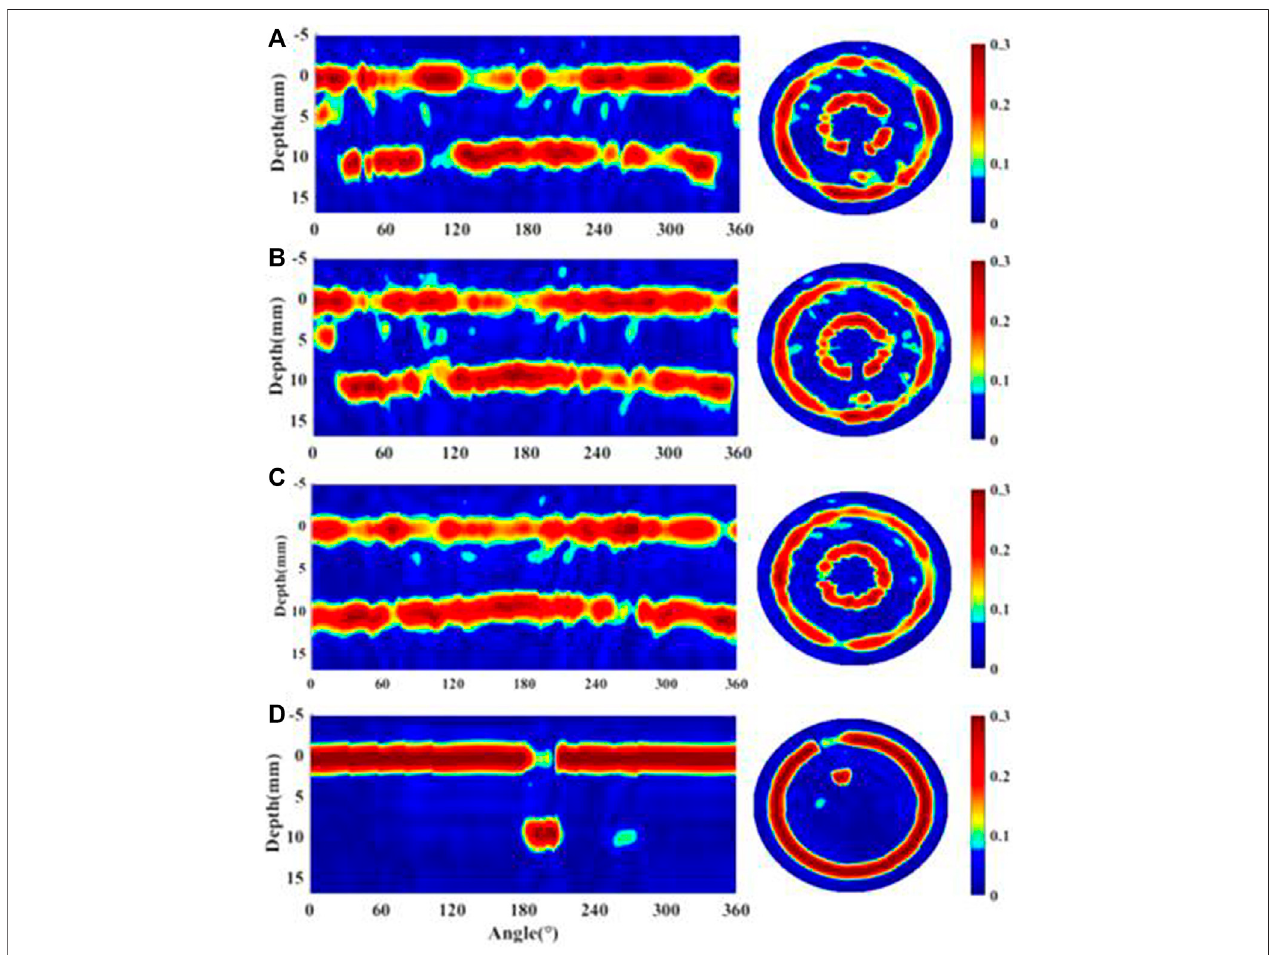
FIGURE 6 | THz B-scan images at different height positions in Cartesian and column coordinates. (A) 15 mm; (B) 25 mm; (C) 45 mm; (D) 55 mm.